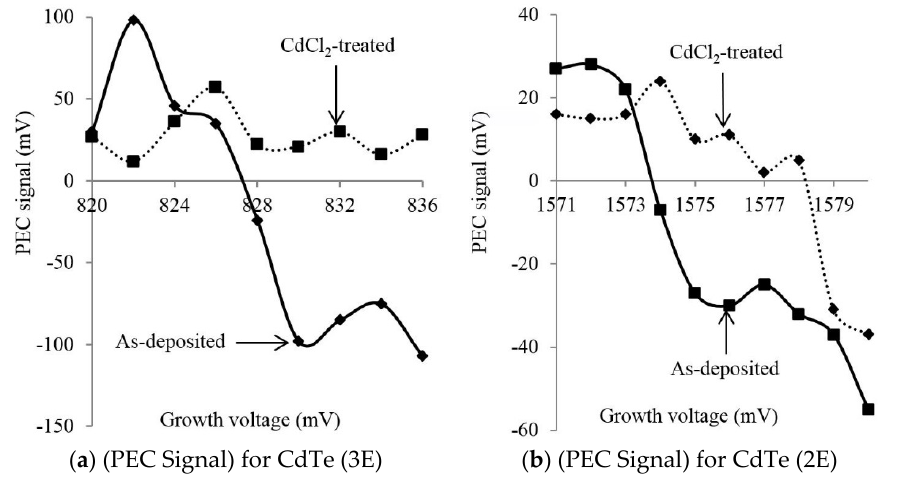
Figure 5. Photoelectrochemical (PEC) cell measurements for as-grown and CdCl 2 -treated CdTe thin films deposited using ( a ) 3E and ( b ) 2E systems at different growth voltages. Samples were heat-treated at 400 °C for 15 min in air in the presence of CdCl 2 .